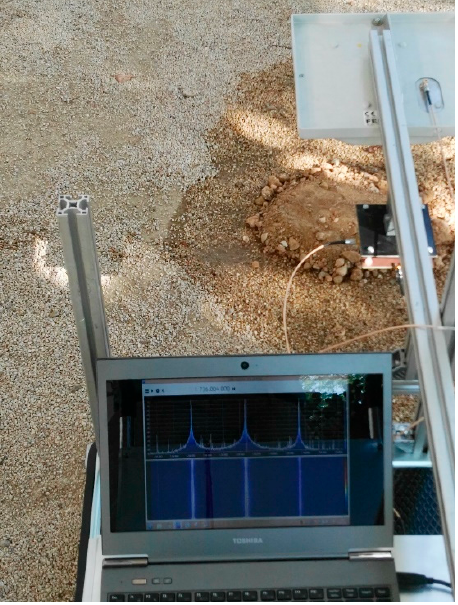
Figure 16 . Photography of the system and measurement setup.